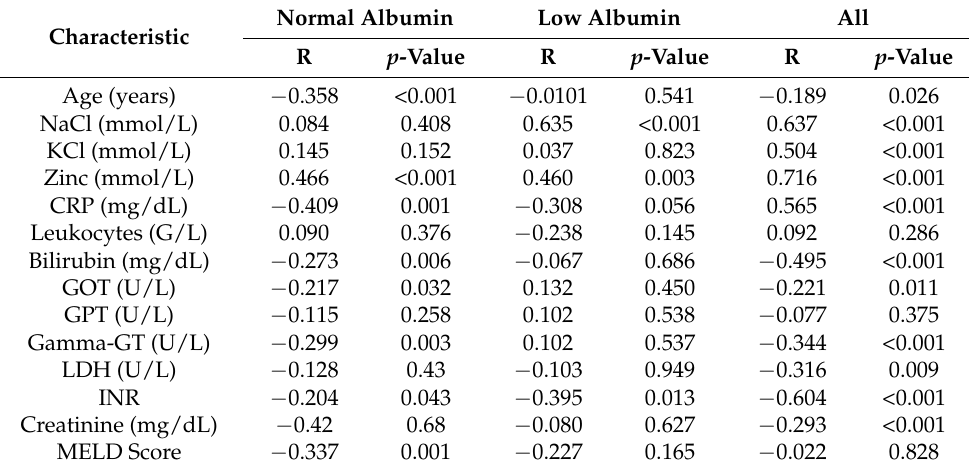
Table 3. Correlation between characteristic and different albumin